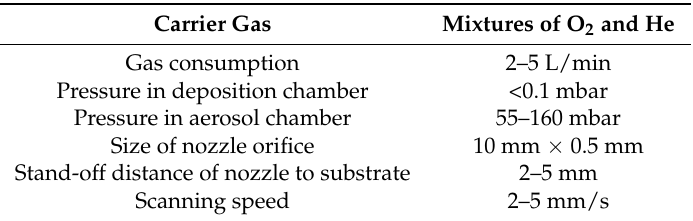
Table 1. Deposition parameters for SnO 2 films.